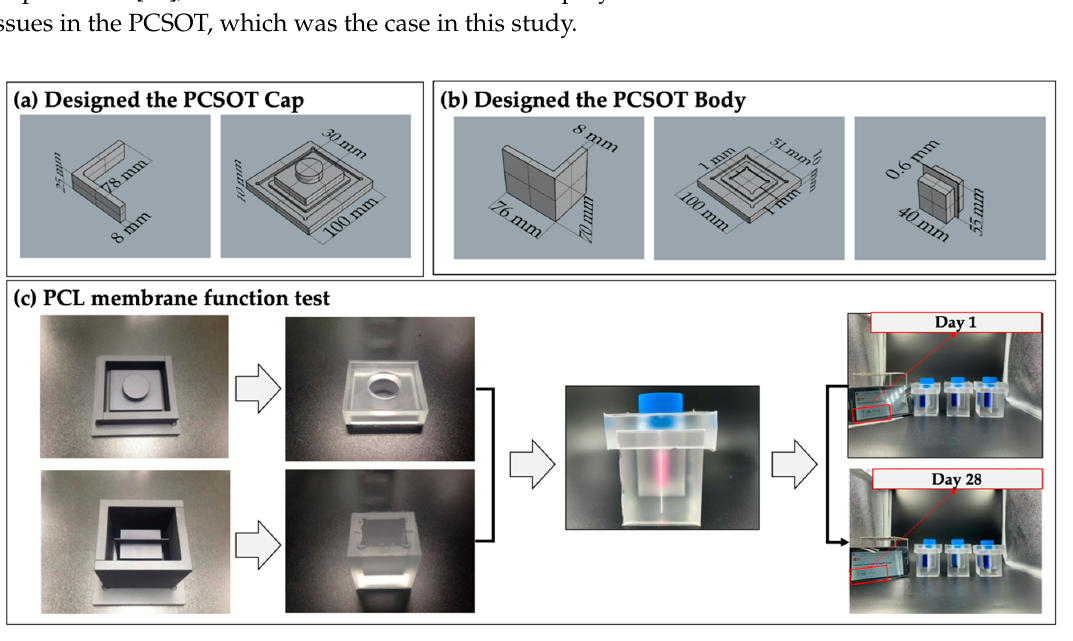
Figure 3. The PCSOT system, the PCL membrane, and the separating function test. ( a ) 3D view of the PCSOT cap in Rhino; ( b ) 3D view of the PCSOT body in Rhino; ( c ) PCL membrane function tests on days 1 and 28.